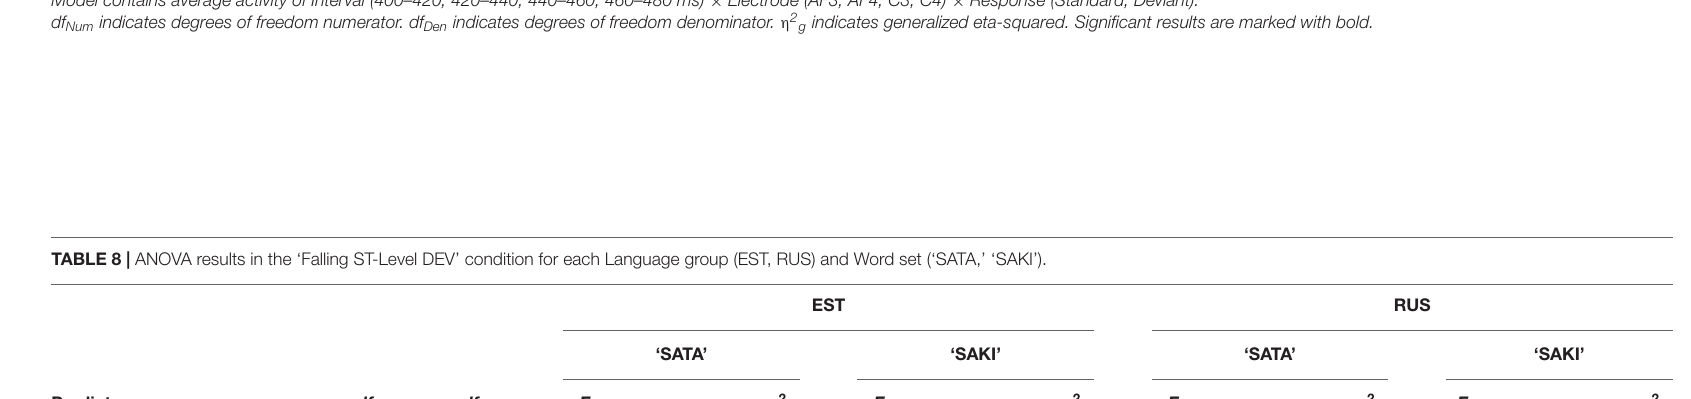
Predictor Electrode